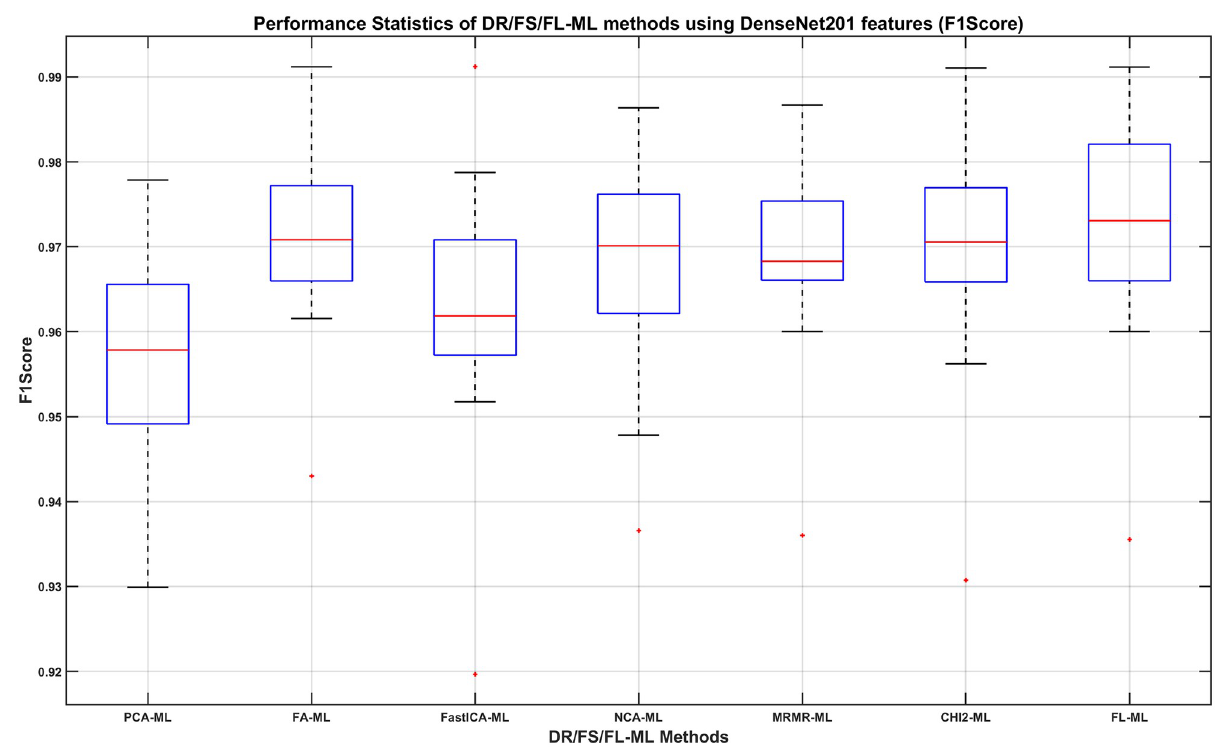
Fig 11. The F1-Score of DR/FS/FL-ML methods using DenseNet201 features. The ML learners used can be found in the second row of Table 10.